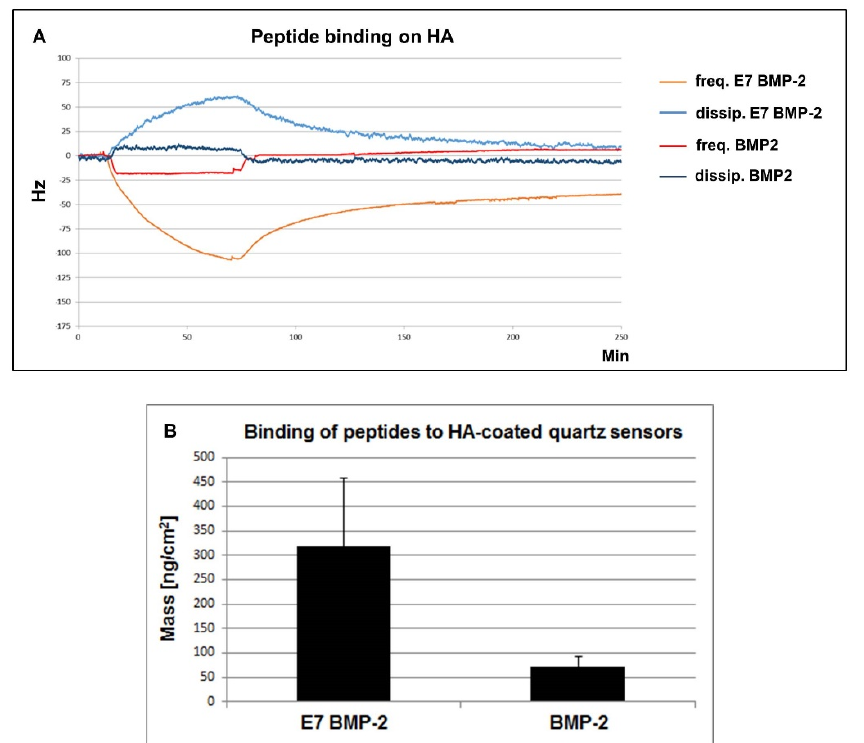
Figure 4. Direct detection of BMP-2 mimicry peptide binding on HA. BMP-2 mimicry peptides (0.6 mg/ml) flowed across the surface of the HA-coated quartz crystals for 45 min and washing with TBS buffer solution followed. ( A ) The red and orange curves illustrate the oscillation frequency and the light and dark blue curves illustrate the dissipation. Note the sudden increase (oscillation frequency) and decrease (dissipation) of the BMP-2 peptide curves after applying the washing buffer, indicating a nearly reversible adsorption-dissociation interaction of peptides without E7 Tag from the HA surface. In contrast, E7 BMP-2 peptides adsorb partly irreversible. ( B ) Quantification of the adsorbed mass of the BMP-2 peptides, with or without E7 Tag, to the HA-coated quartz sensors. Oscillation frequency (red and orange curves) and dissipation (light and dark blue curves)